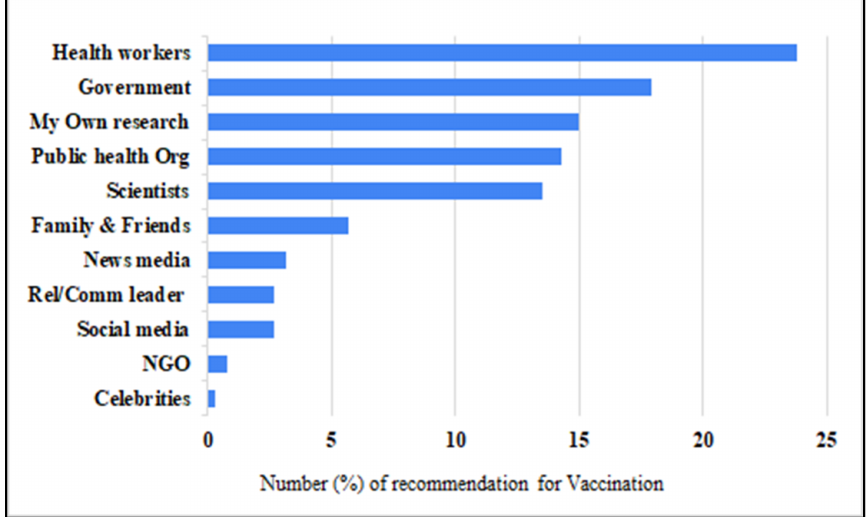
Figure 5. Distribution of recommendations that enhanced COVID-19 vaccination among